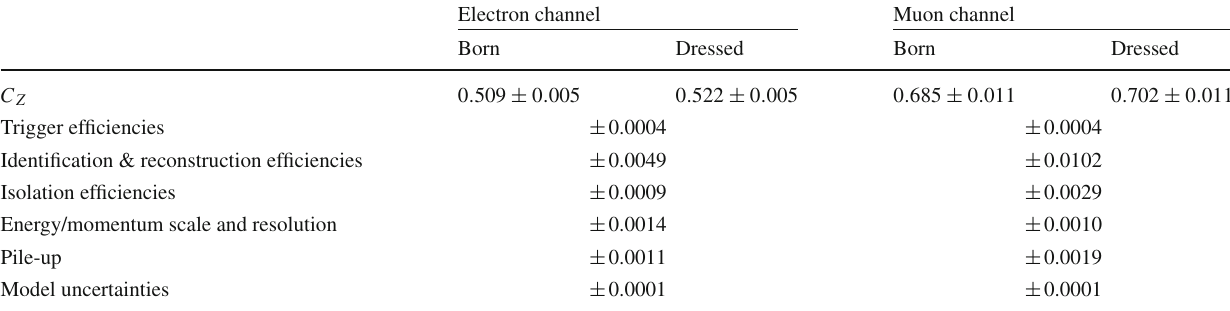
Table2 Overviewofthedetectorefficiencycorrectionfactors, C Z